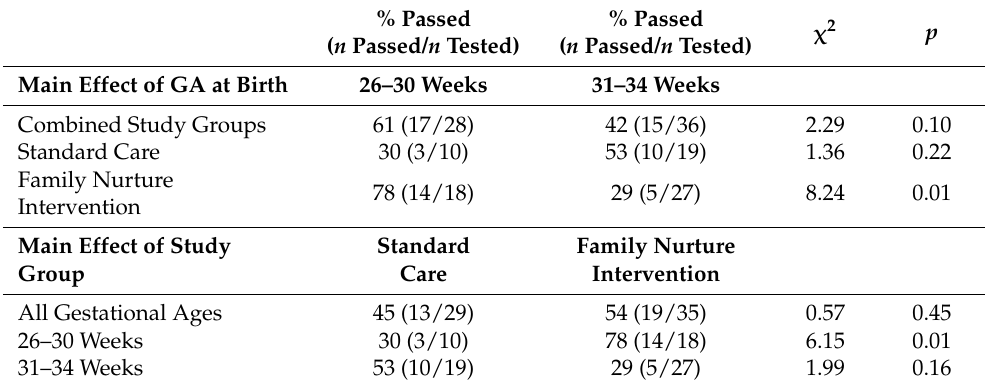
Table 2. Main effects of gestational age at birth and study group assignment on task performance. % Passed ( n Passed/ n